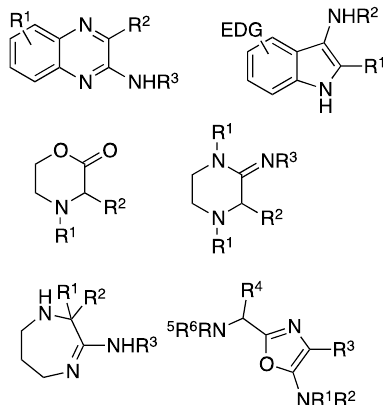
Figure 1. Examples of heterocycles obtained through an interrupted Ugi reaction.